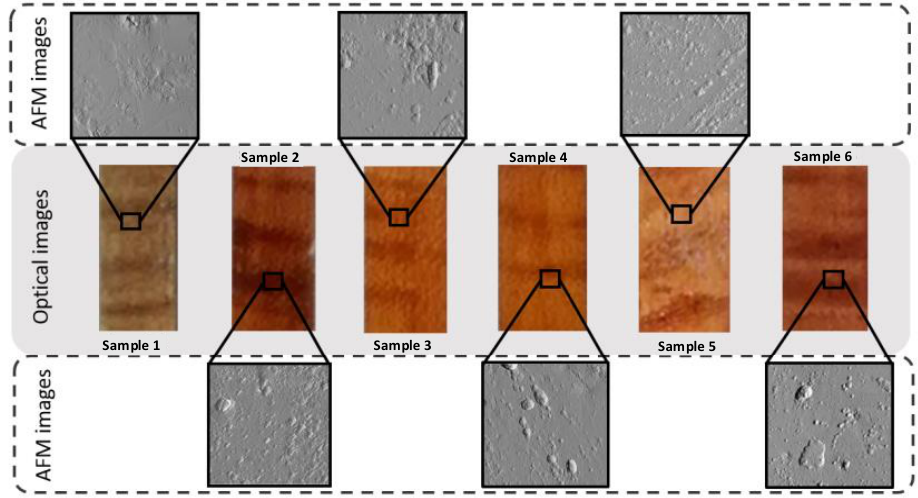
Figure 2. Model systems optical images together with AFM images of samples (1 to 6) before ageing: oil-based (1 and 5); AFM image 1, z scale image = 159.4 nm/Roughness 19.1 nm; AFM image 5, z scale image = 164.5 nm/Roughness 18.2 nm; and spirit-based varnish layers (2, 3, 4, 6); AFM image 2 z scale image = 235.6 nm/Roughness 10.5 nm; AFM image 3, z scale image = 522.6 nm/Roughness 33.6 nm; AFM image 4, z scale image = 823.9 nm/Roughness 18.6 nm; AFM image 6, z scale image = 260.0 nm/Roughness 14.5 nm on top of maple wood over preparation layers of various compositions (Table 1).